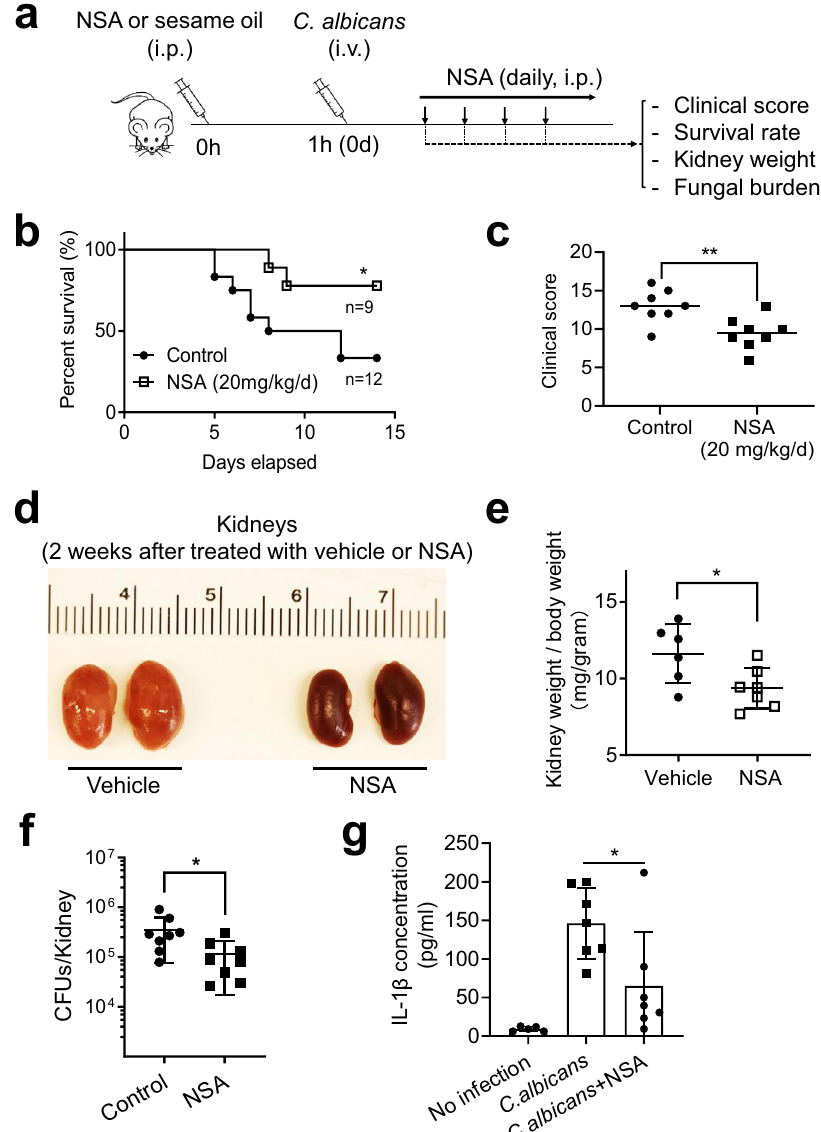
Fig. 9 GSDMD antagonist NSA alleviates C. albicans infection in mice. a Experimental scheme for assessing the effects of pharmacologic inhibition of GSDMD on C. albicans infection. Mice were intravenously challenged with 2 × 10 5 CFU C. albicans 1 h after intraperitoneal injection of sesame oil alone (control) or NSA (dissolved in sesame oil, 20 mg/kg body weight). The challenged mice received daily NSA treatment (20 mg/kg body weight) and were monitored for 15 days. Controls were injected with sesame oil only during the same time period. b Kaplan-Meier survival plots of C. albicans -challenged mice. Survival rates were analyzed using Kaplan-Meier survival curves and log-rank testing. p = 0.0427 vs . control. c Clinical score of C. albicans